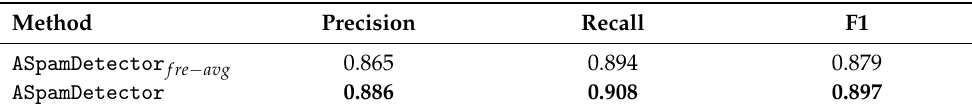
Table 6. Validating the importance of the proposed frequency-based attention mechanism in the graph attention network.